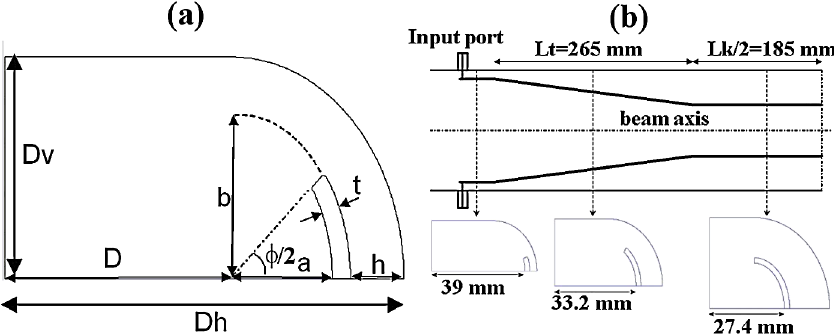
FIG. 6. (a) Generic cross section of the DA(cid:1)NE kicker. (b) Final optimized dimensions of the kicker (half